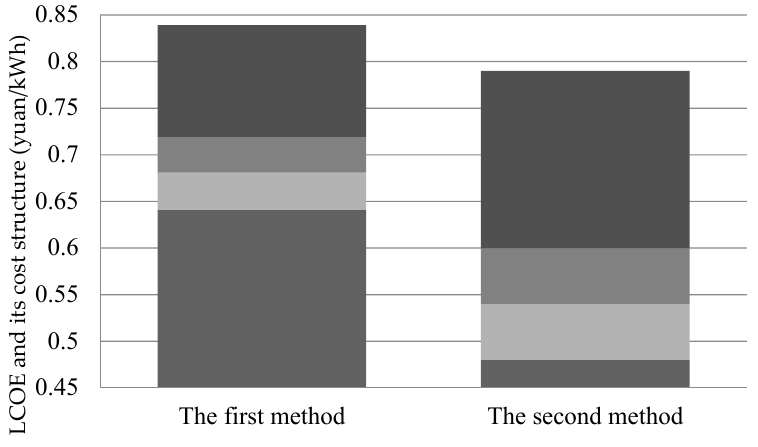
Figure 2. Cost structure.